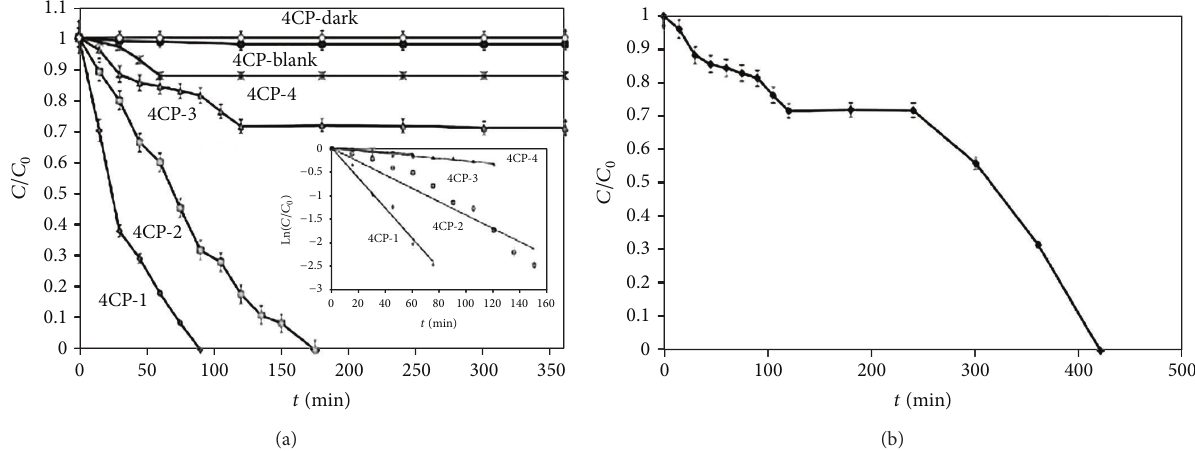
Figure 4: (a) The degradation of 4CP in contact with BFO nanofibers as a result of irradiation by the light with the wavelength of 385 nm. The gradual decrease in the different concentrations (1, 2, 5, and 7.5 𝜇 g/mL) of 4CP compared to the insignificant change in concentration for 4CP-blank and 4CP-dark is depicted. The inset illustrates the application of pseudo-first-order kinetics for the degradation of the 4CP, (b) the degradation of 4CP for 4CP-sat sample. The trend shows a stop in the degradation process at 120min probably due to surface saturation, and it is resumed after the BFO nanofiber mat is